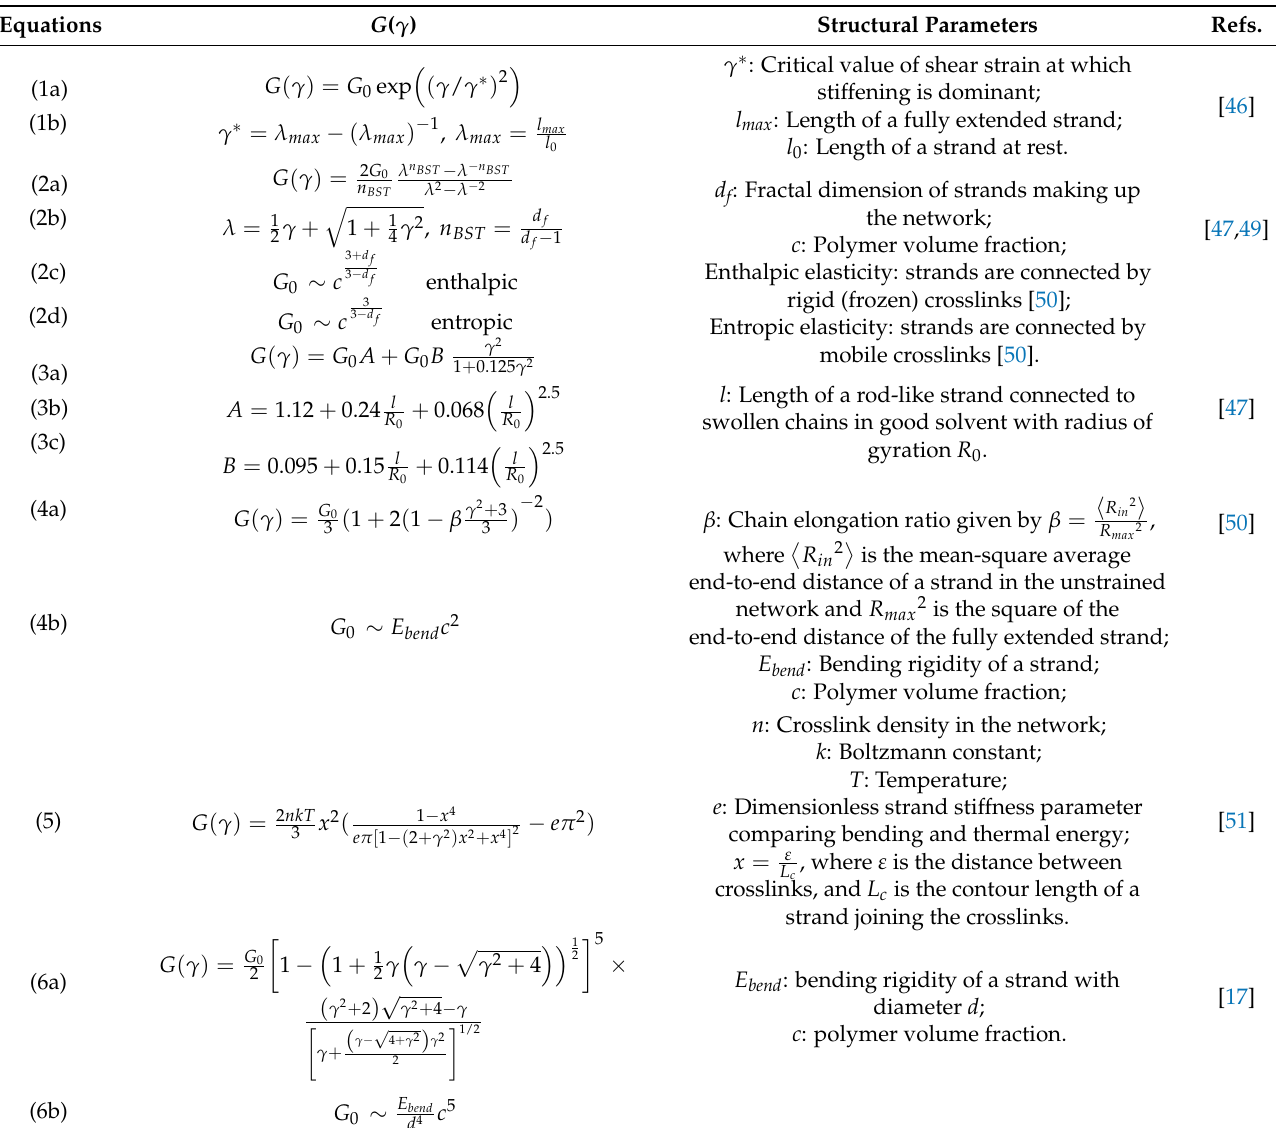
Table 3. Theoretical predictions for the shear elastic modulus G and its nonlinear dependence G ( γ ) with shear strain γ . G 0 is the (linear) elastic shear modulus at small strain. References to the original papers where the G ( γ ) expressions have been first introduced are gathered in the last column labelled